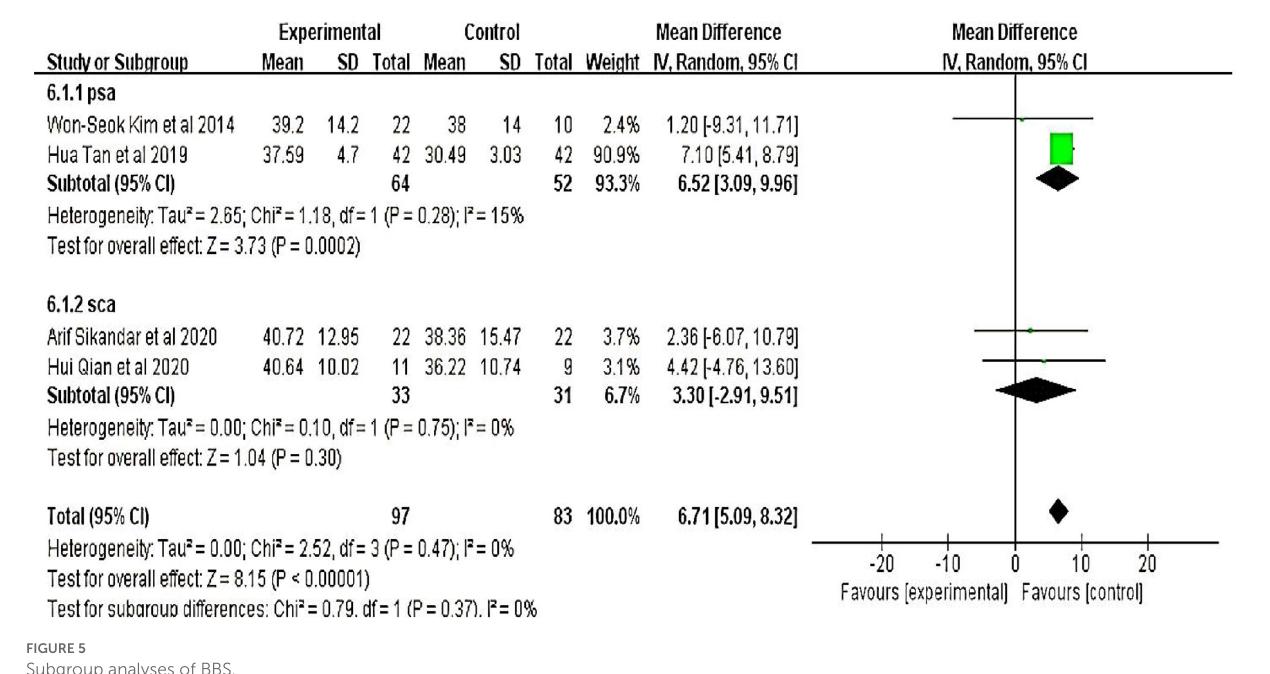
FIGURE5 Subgroup analyses of